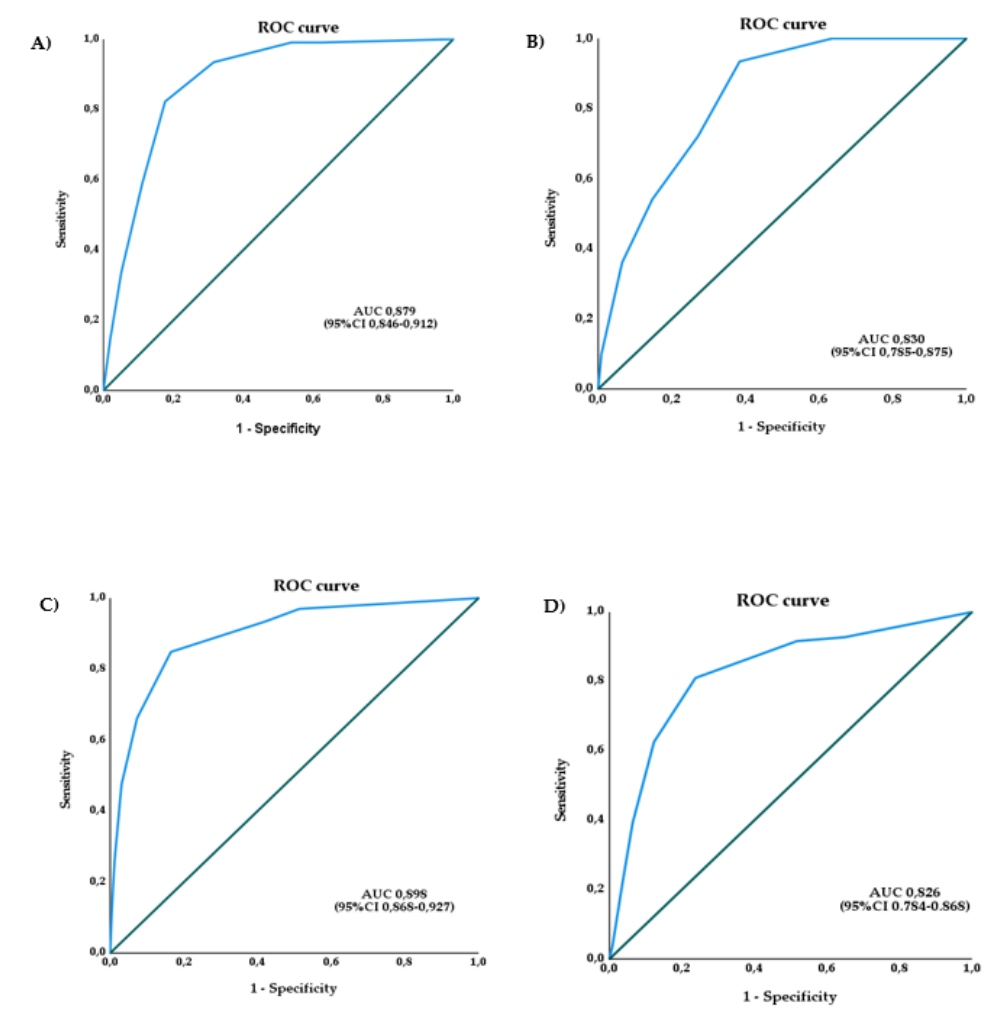
Figure 1. ROC curve for death and for worsening in seven days in the derivation and validation cohorts: ( A ) ROC curve for death in the derivation cohort; ( B ) ROC curve for death in the validation cohort; ( C ) ROC curve for worsening within seven days in the derivation cohort; ( D ) ROC curve for worsening within seven days in the validation cohort. AUC: Area Under the Curve.